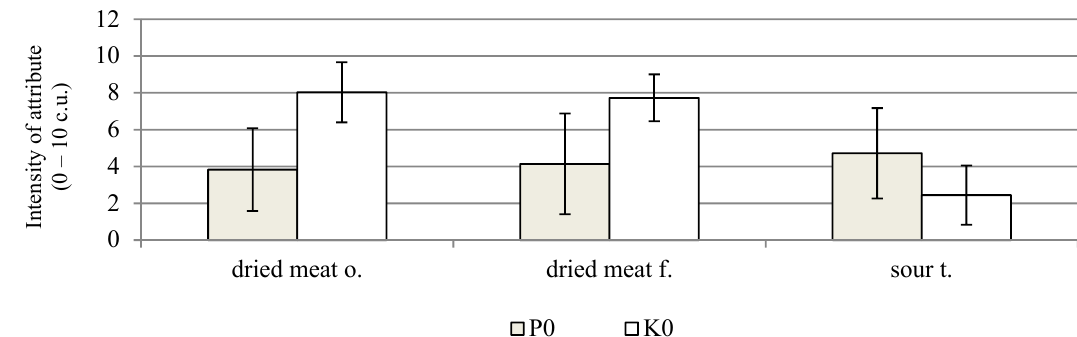
dried meat o. dried meat f.